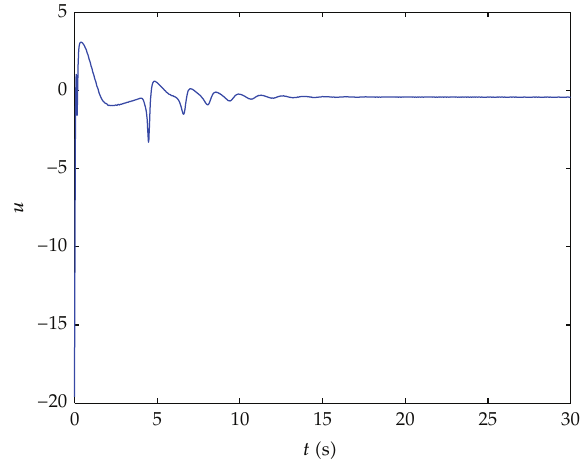
Figure 4: The trend of the T-S